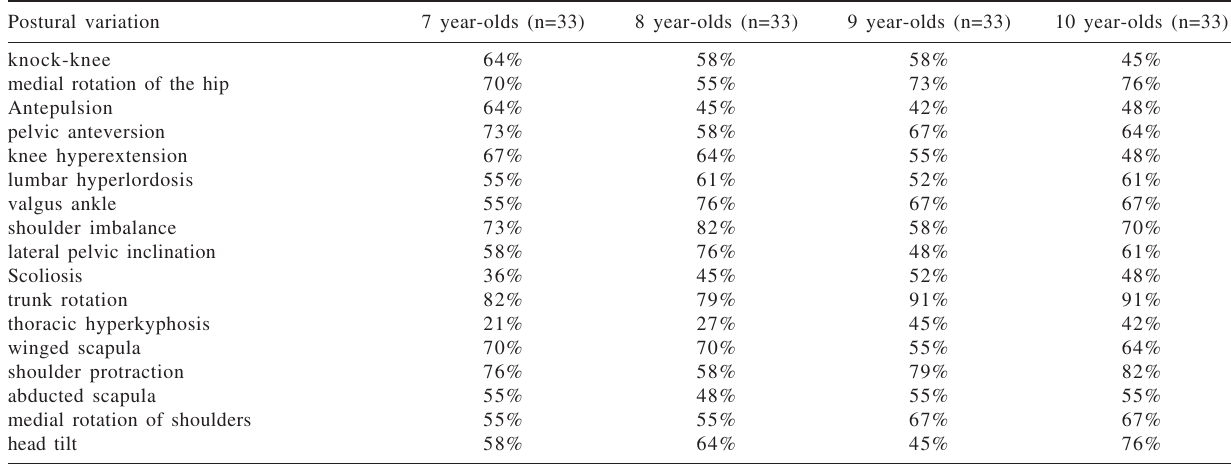
Table 2 - Primary postural deviations in 133 girls aged 7 to 10 years of age. Postural variation